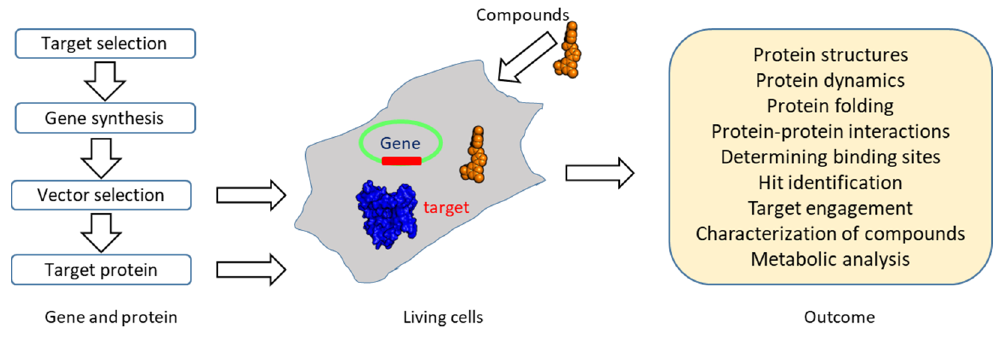
Figure 6. An overview of in-cell NMR. In-cell NMR can be conducted in different cells. Suitable expression vectors (highlighted in green) should be selected for target protein expression. Proteins can also be purified in vitro and transformed/injected into cells using various methods [63,156,169]. The outcome of in-cell NMR is listed in the figure.